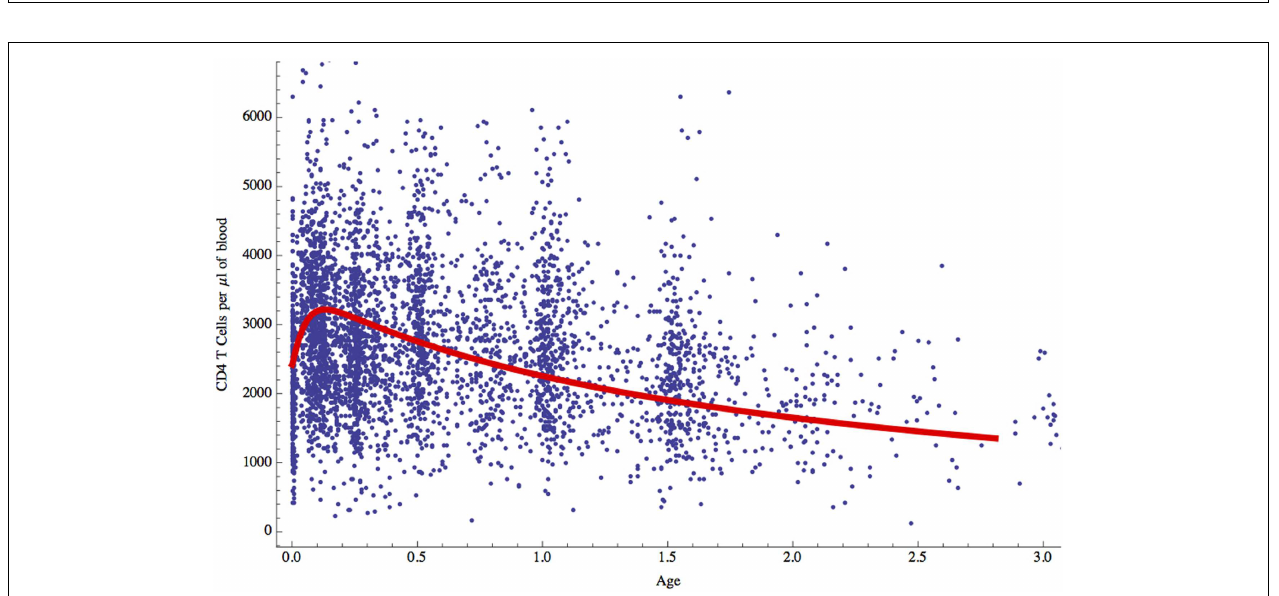
FIGURE 5 | Effect onT cell dynamics of changes in resource concentration for entry into cell division ( ε ) and survival ( ρ ) . Other parameters are as in Table 1 . It is noteworthy that the homeostatic equilibrium is more sensitive to changes in the resource parameter ( ε ) for entry into cell division than the parameter ( ρ ) for survival.